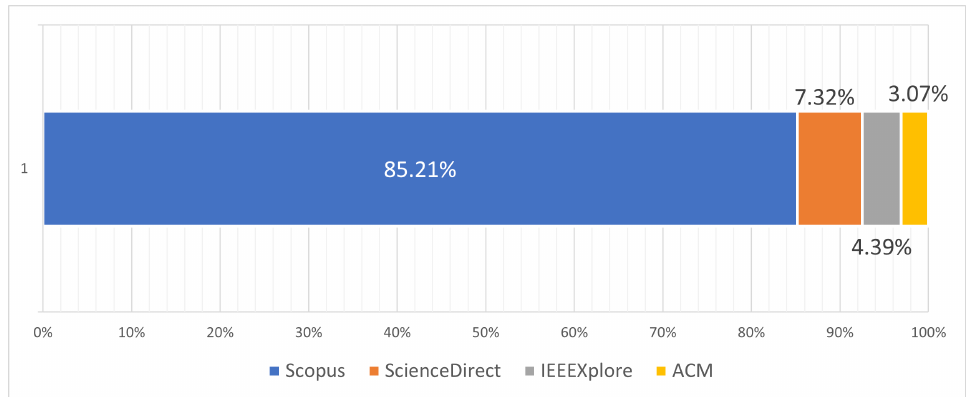
Figure 5. Articles distribution by scientific